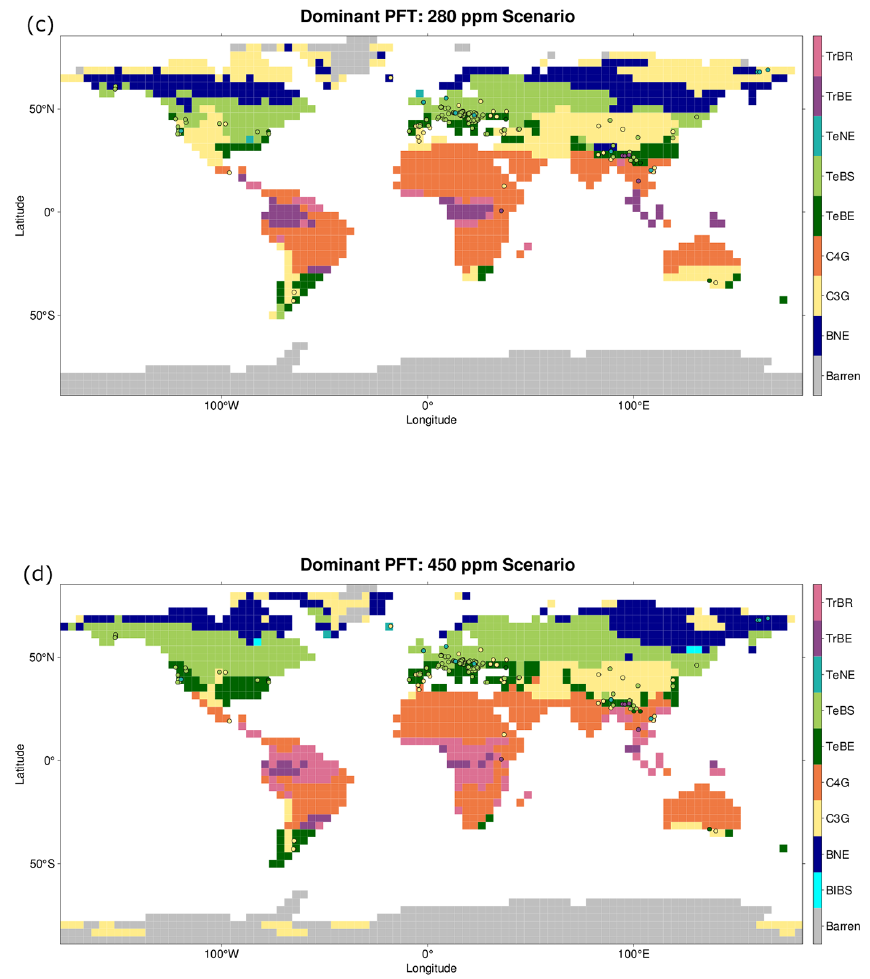
Figure 1. Modelled Late Miocene (Tortonian, 7–11Ma) vegetation, using the ECHAM5-MPIOM AOGCM to drive LPJ-GUESS. (a) The biome distribution with 280ppm CO 2 concentration, with the agreement index (AI) match overlain for palaeobotanical data. (b) The biome distribution with 450ppm CO 2 concentration, with the AI match overlain for palaeobotanical data. (c) The dominant PFTs, with palaeob- otanical data classified with same PFT scheme as the model overlain, with 280ppm CO 2 concentration. (d) The dominant PFTs, with palaeobotanical data classified with same PFT scheme as the model overlain, with 450ppm CO 2